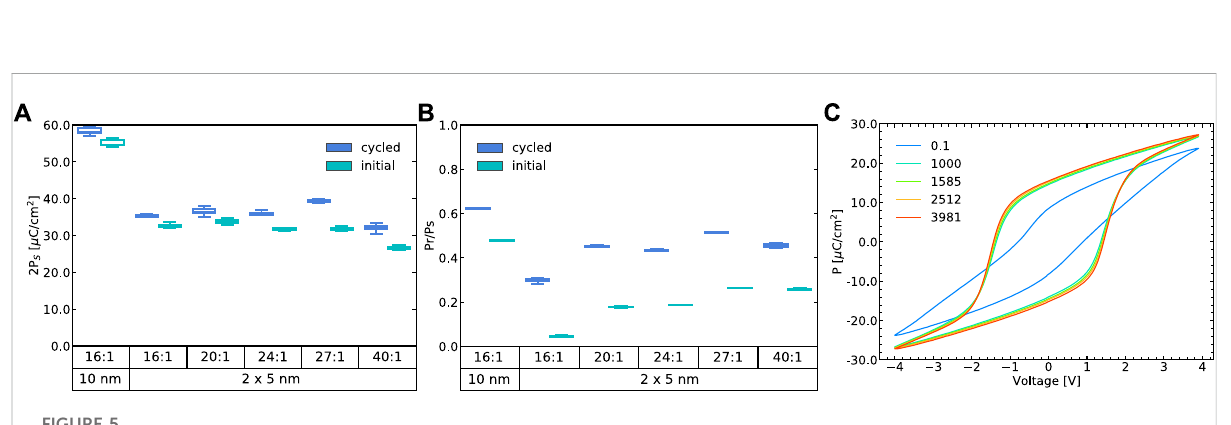
FIGURE 4 ElectricalanalysisofHZO/Al 2 O 3 heterostructureswithvaryingZrcontent. (A,B) visualizetheremanent(2 PR)andsaturated(2 PS)polarizationof the pristine and cycled device for 3 V cycling and DHM amplitude, respectively. 2PS values close to zero indicate breakdown. Strong antiferroelectric-like behavior is observed inthe polarization-voltage hysteresis of the2 × 5 nm HZO sample with a cycling ratio of Hf:Zr 3:7 (C) . The number of applied electric stress cycles is provided in the legend.